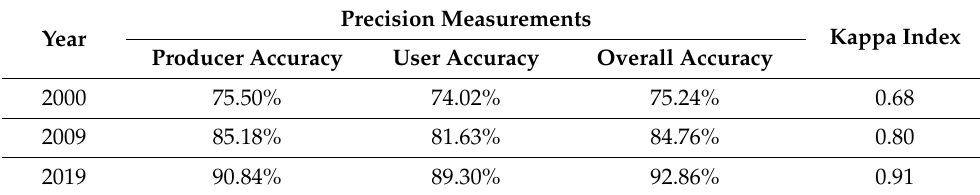
Table 3. Overall accuracy evaluation of the supervised classification and kappa index.